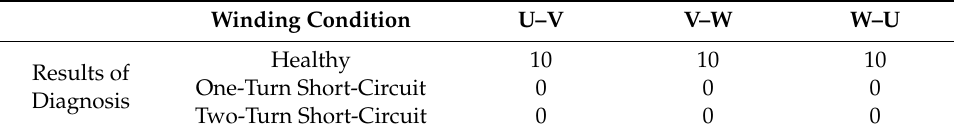
Table 3. Diagnostic results for the 1.5-kW motor 2 (healthy).